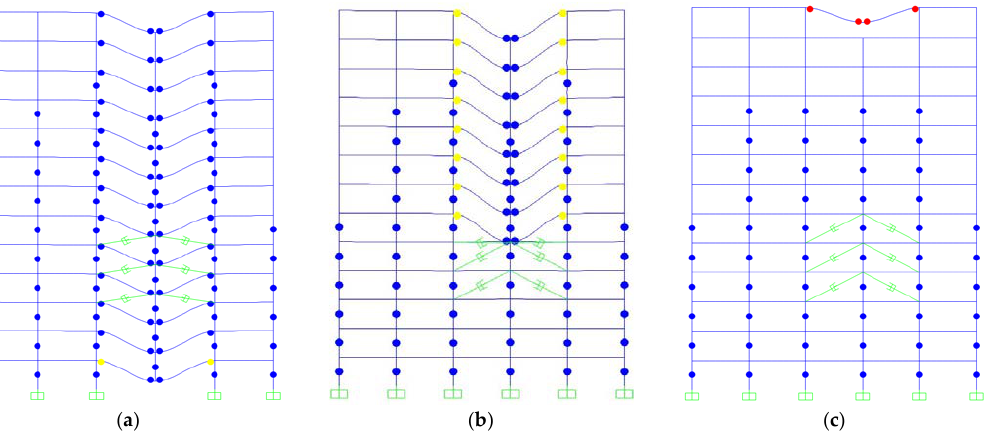
Figure 13. Hinge formation in the viscously damped frame only in certain stories exposed to column removal in ( a ) story one, ( b ) story six, and ( c ) story thirteen.